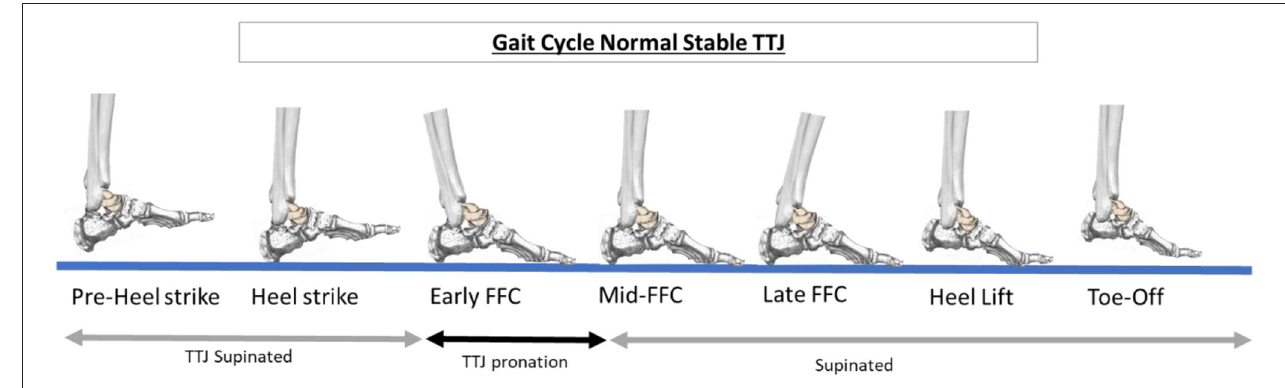
FIGURE 2 | Schematic showing the portions of the gait cycle with a normal stable talotarsal joint (TTJ). It also shows when the TTJ should be in a supinated or pronated alignment. “FFC” is full plantar foot contact.